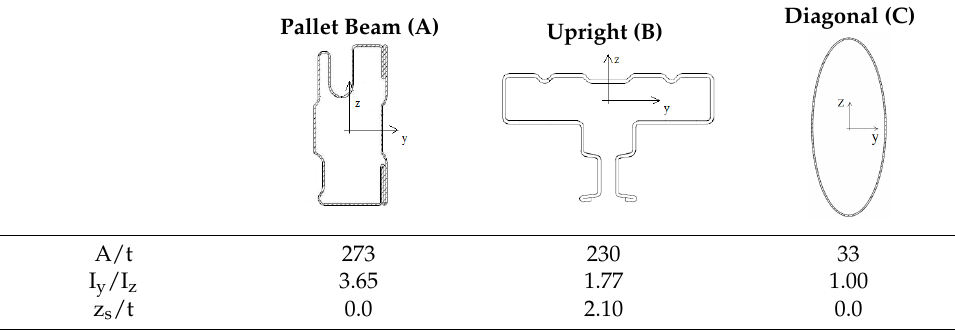
in terms of relationships between the base-plate connection bending moment ( M base ) di- vided by the resistant bending moment of the upright ( M c ) versus rotation φ base . Like for beam-to-column joints, initial elastic stiffness ( S j , base ) is represented by a dashed thick black line, corresponding to the value of 2.21 × 10 6 Nmm/rad, which is the unknown stiffness to approximate via the characterization